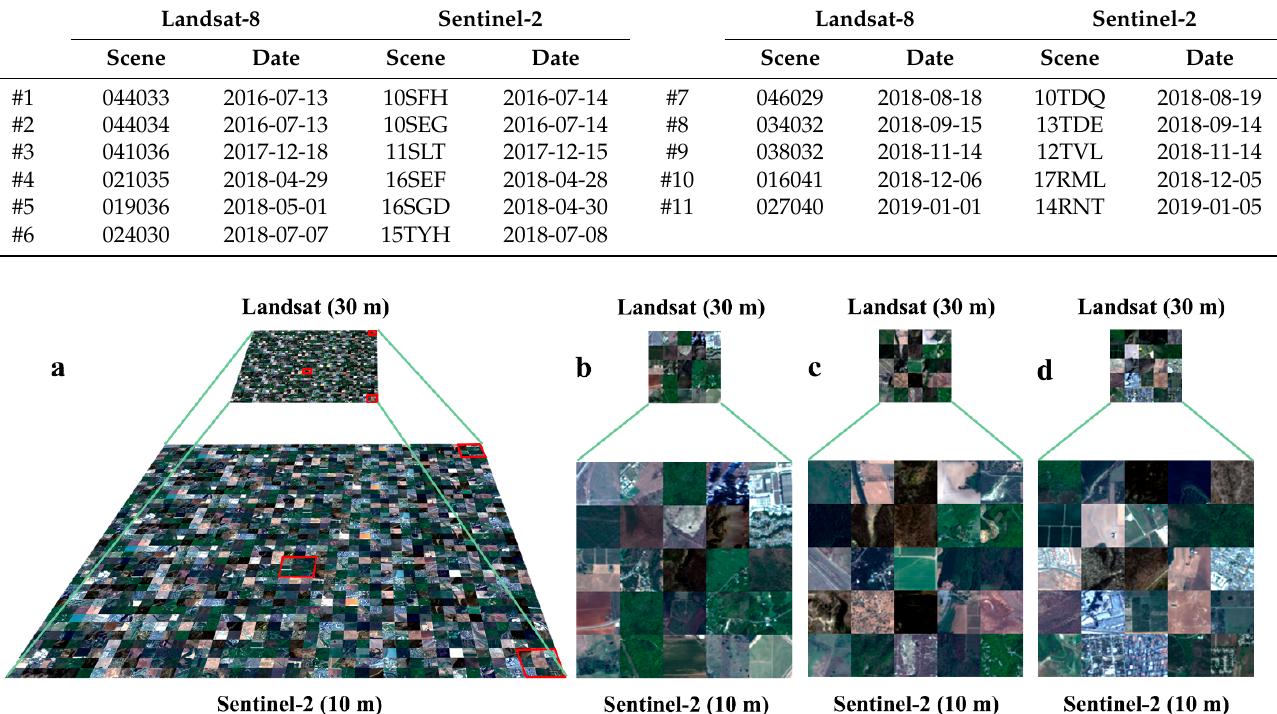
Figure 4. The example mosaics of paired Landsat and Sentinel-2 imagery used for the training and validation process, in which area? ( a ). Details are also shown in ( b – d ) for three example subsets highlighted in red squares in ( a ).